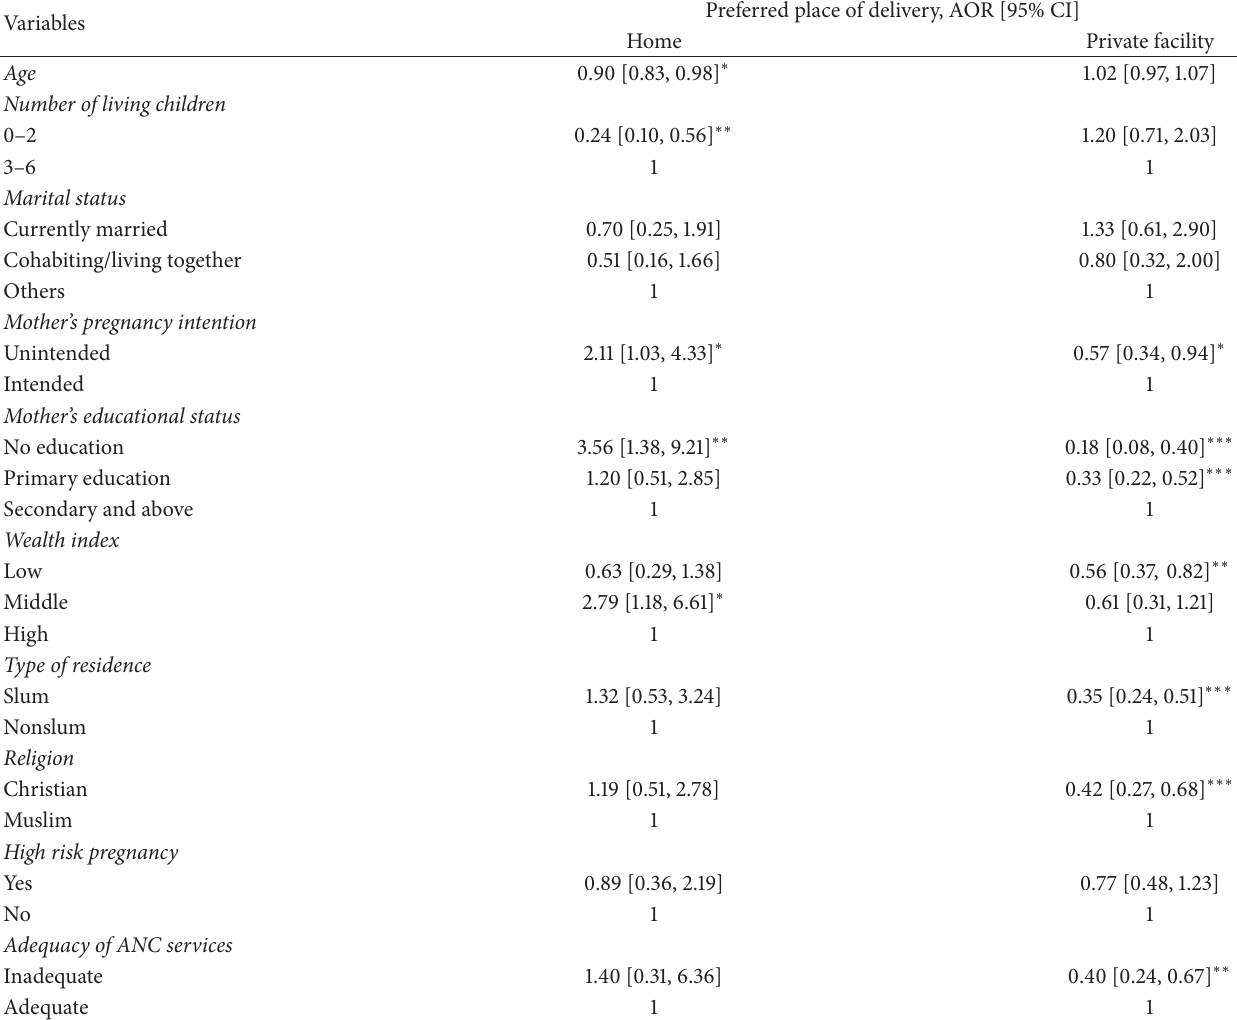
Table 2: Odds ratios from multinomial logistic regression for preferences for places to give birth, Addis Ababa, January 2014.